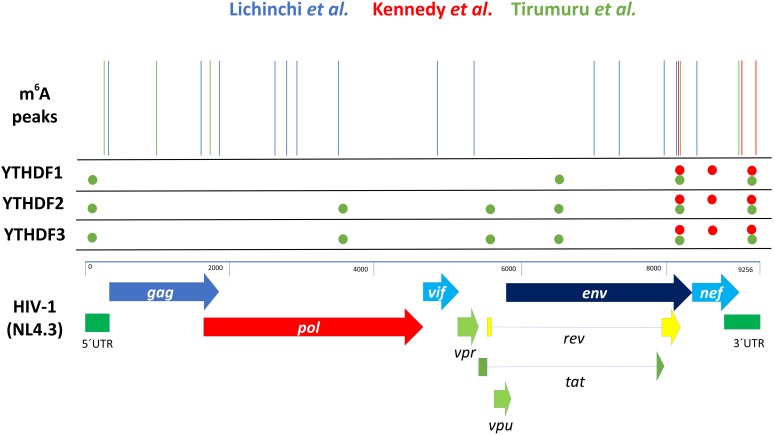
Summary of HIV-1-related m6A-seq and CLIP-seq data. Schematic, not to scale, representation of the position of the m6A peaks reported for the HIV-1 genome. The NL4.3 strain was used as a reference to compare data reported by Lichinchi et al. (2016a) (blue lines), Kennedy et al. (2016) (red lines) and Tirumuru et al. (2016) (green lines). It should be mentioned that Lichinchi et al. (2016a) used the HIV-1 LAI strain to perform m6A-seq. The position of YTHDF1-3 binding sites reported by Kennedy et al. (2016) (red circles) and Tirumuru et al. (2016) (green circles) are also represented.